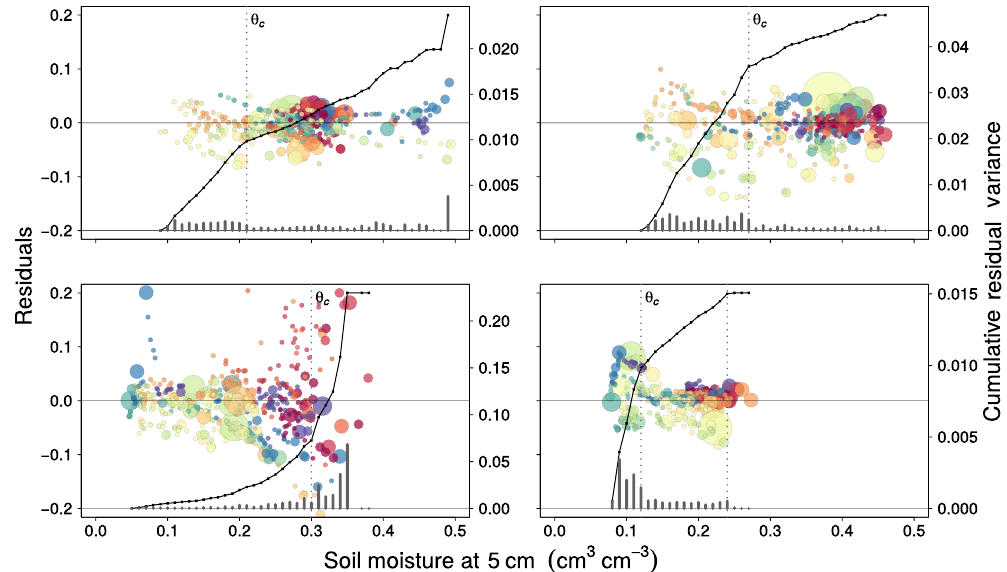
Figure 5. Residual variance plots from the fitted loess function. Vertical bars at the bottom of each plot represent the variance for every 0.1cm 3 cm − 3 interval. The cumulative residual variance (gray line) shows a change in slope at θ c , indicated by the vertical black dashed line. This separates the soil moisture values into a range with higher variance (steeper slope) and another range with lower variance (gentler slopes). The range with higher variance is considered decoupled, and vice